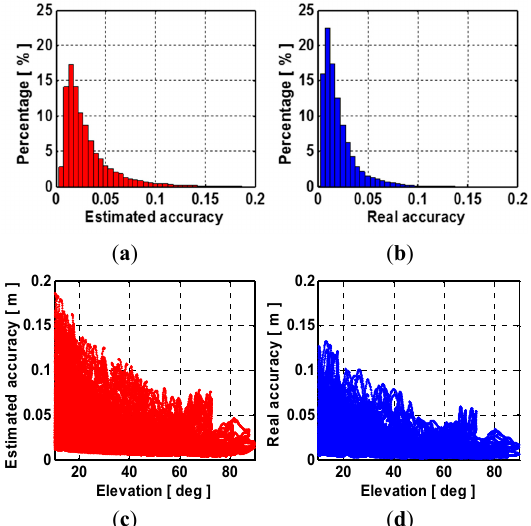
Figure 4. ( a ) distribution of peak-to-peak amplitudes of estimated accuracy of ionospheric correction; ( b ) distribution of peak-to-peak amplitudes of real accuracy of ionospheric correction; ( c ) peak-to-peak amplitudes of estimated accuracy of interpolated ionospheric corrections against elevation function; ( d ) peak-to-peak amplitudes of real accuracy of interpolated ionospheric corrections against elevation function.